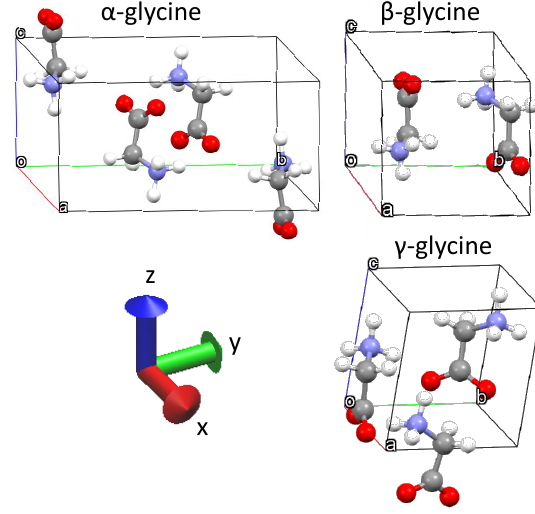
Figure 1. Unit cells of α -, β -, and γ -glycine. Arrows indicate the x-, y-, and z- directions in which the e-field was